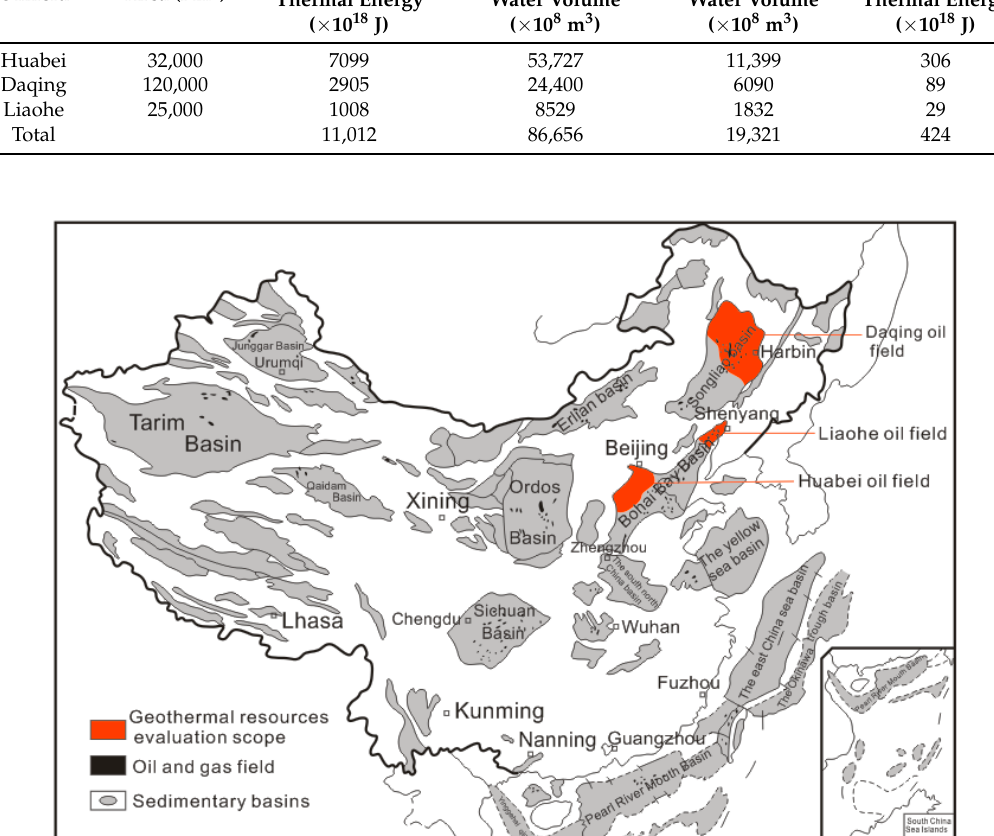
Figure 4. Major hydrocarbon basins and geothermal resource assessment scope.